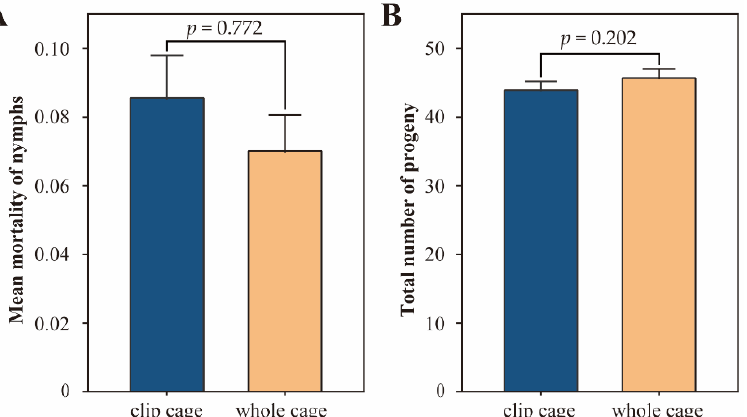
Figure 5. Clip cages did not significantly affect nymph mortality and adult fecundity of Sitobion avenae . ( A ) Mortality of 15 newborn nymphs reared for 6 days ( n = 67). ( B ) Number of offspring produced by 5 adults during a 6 day reproduction period ( n = 67). Differences were determined by an unpaired t -test.